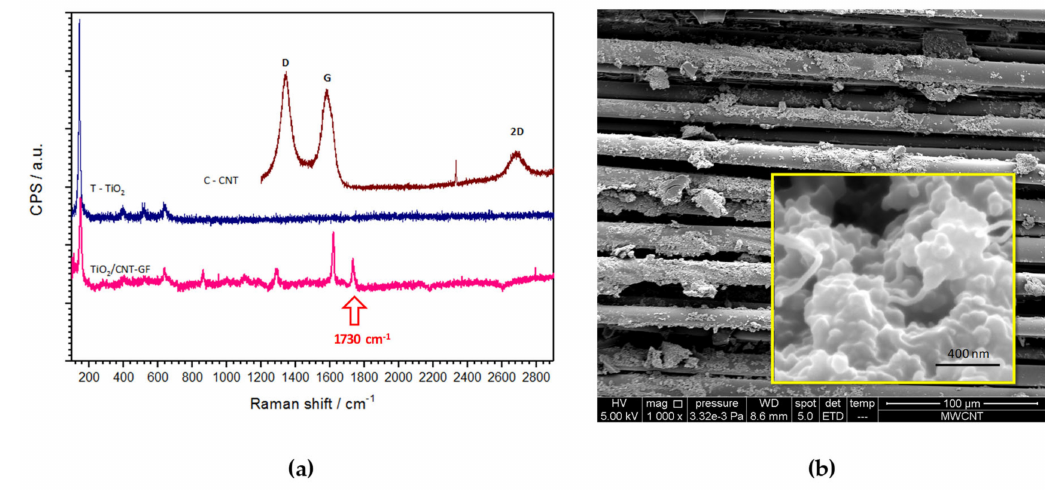
Figure 4. ( a ) Raman spectra of the photocatalytic constituents and composite film on glass fiber mesh; ( b ) SEM image of TiO 2 / CNT-GF at 1000 magnification and 200,000 × (given as embedded